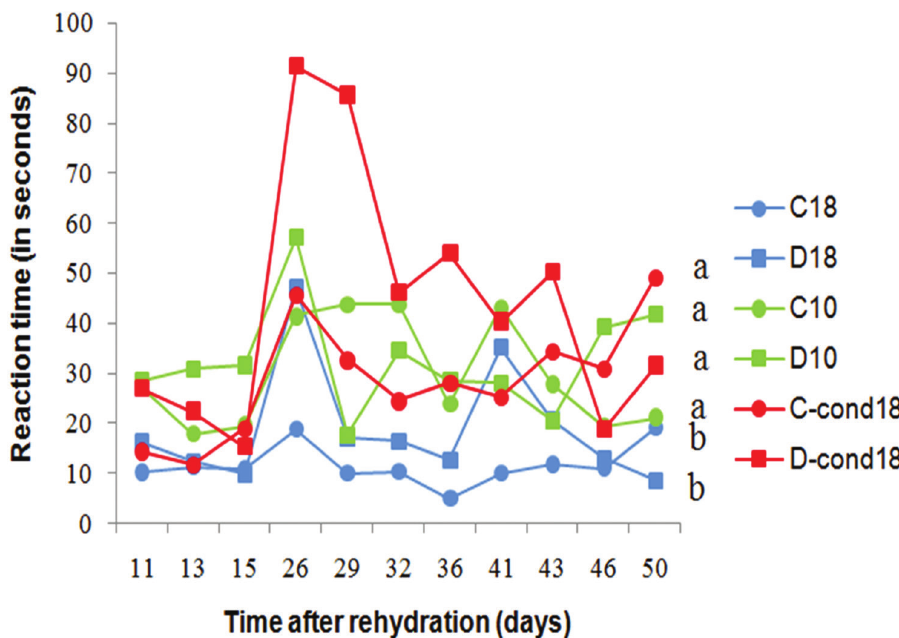
Figure 3. Mean reaction time (in seconds) of individuals of each treatment for each observation time between 8 and 50 days after rehydration ( n = 11 observations). SD has been removed for clarity. Time affected significantly the reaction time ( p < 0.05; mixed ANOVA). The interaction between time and treat- ments did not caused significant differences ( p > 0.05; mixed ANOVA). Letters in right indicate significant differences in reaction time between treatments ( p < 0.001; Student t pairwise with Bonferroni